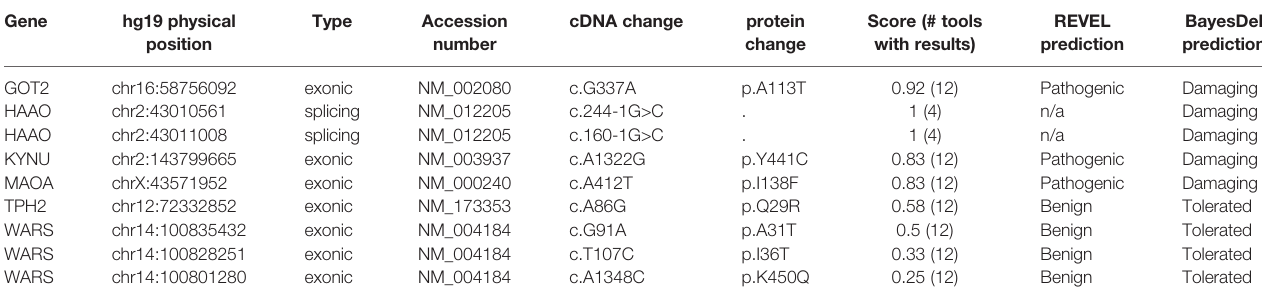
TABLE 2 | Novel protein-altering variants in sporadic ALS cases. Gene hg19 physical